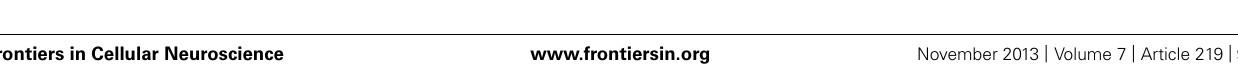
Frontiers in Cellular